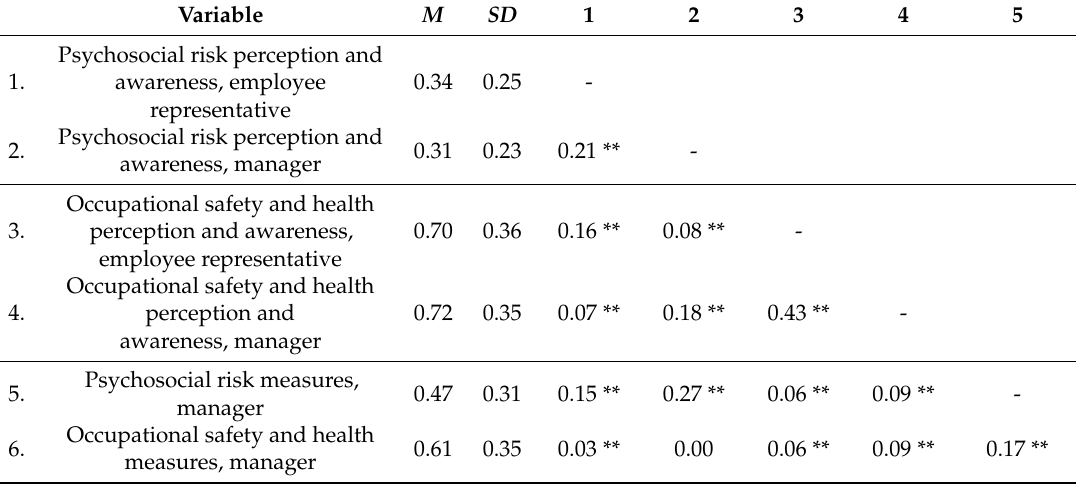
Table 2. Means, standard deviation and intercorrelations among study variables ( n = 6882).